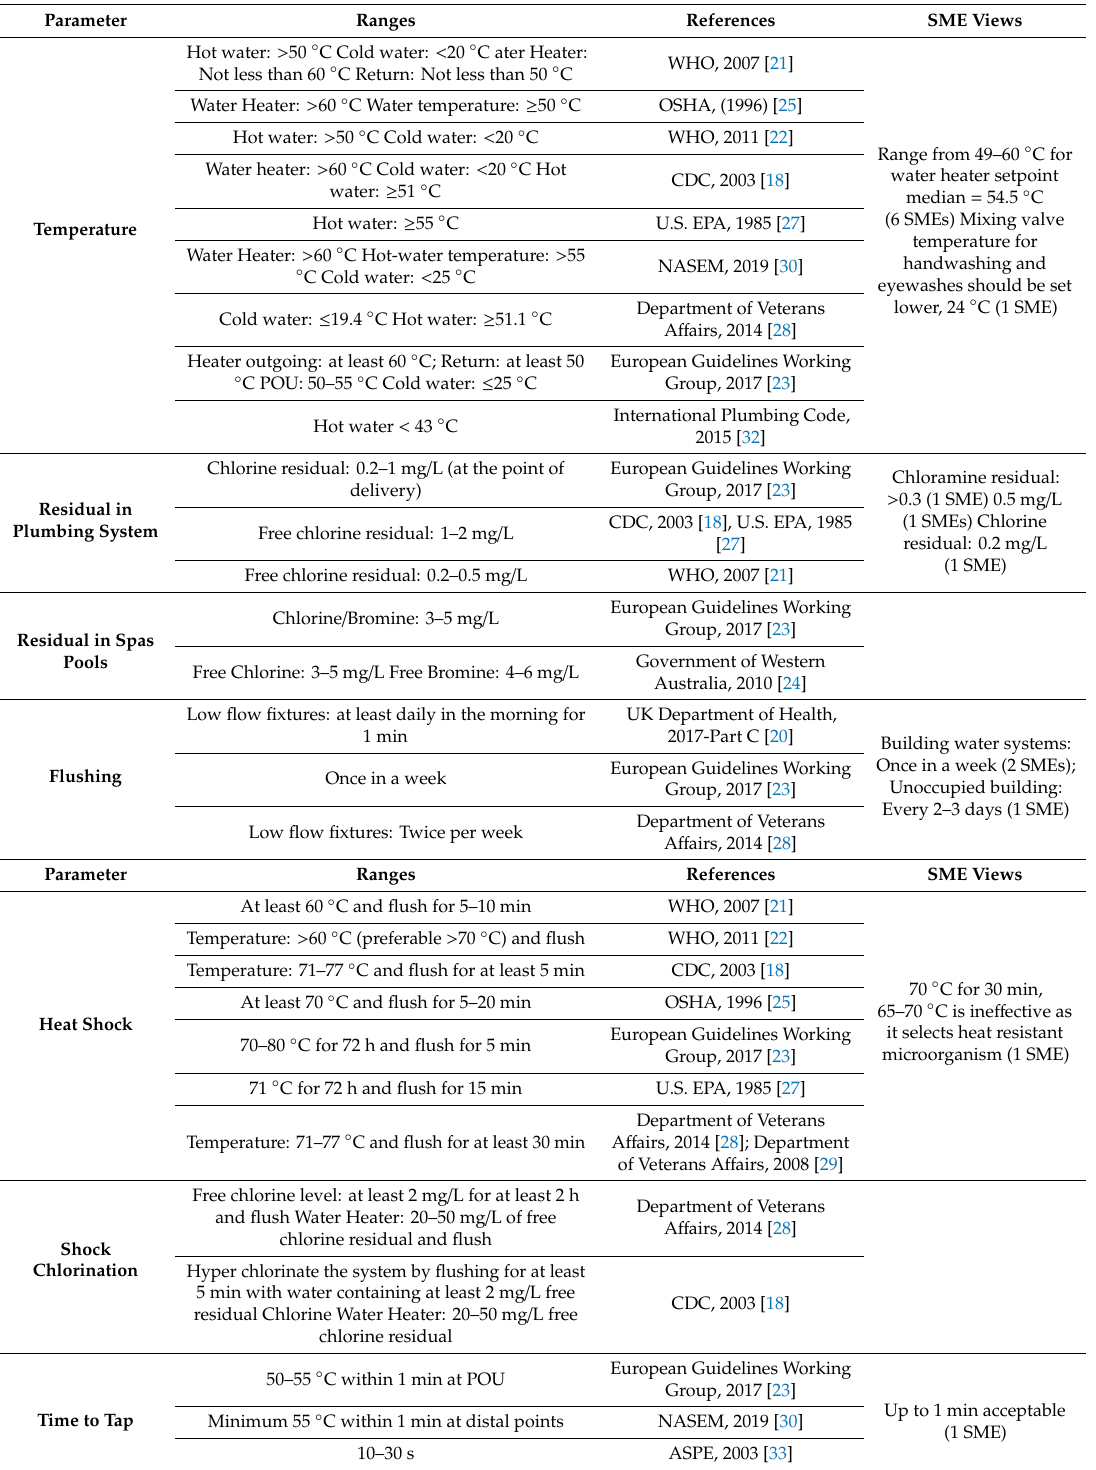
Table 4. Water quality parameters and